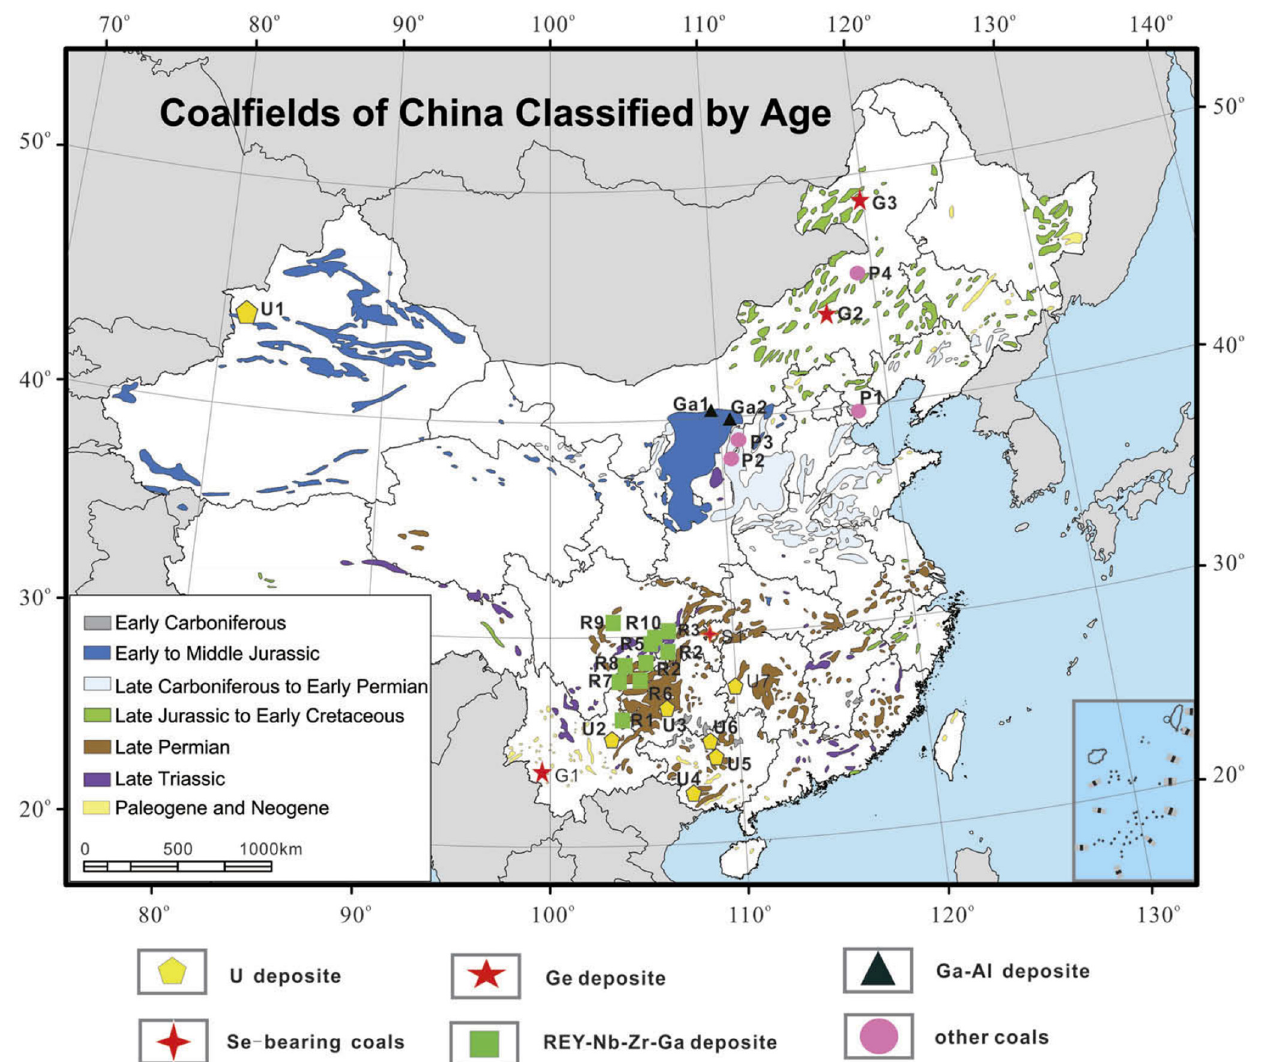
Figure 16. Locations of some coalfields in China